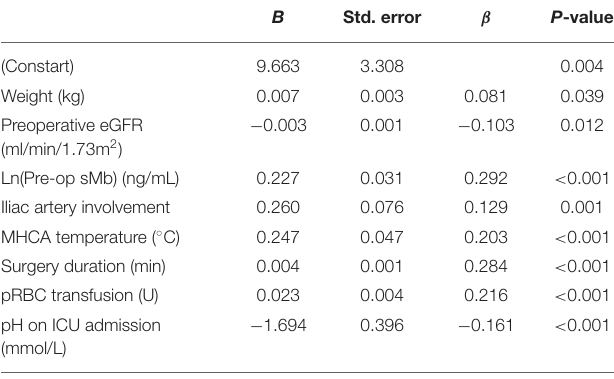
TABLE 5 | Multiple linear regression of factors related to the POD1